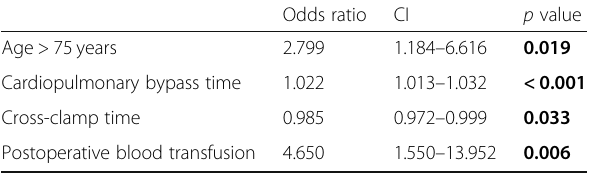
Table 4 The multivariate logistic regression analysis for 30 days mortality. Variables included in the regression analysis: age, EuroSCORE II, aortic aneurysm, aortic calcification,